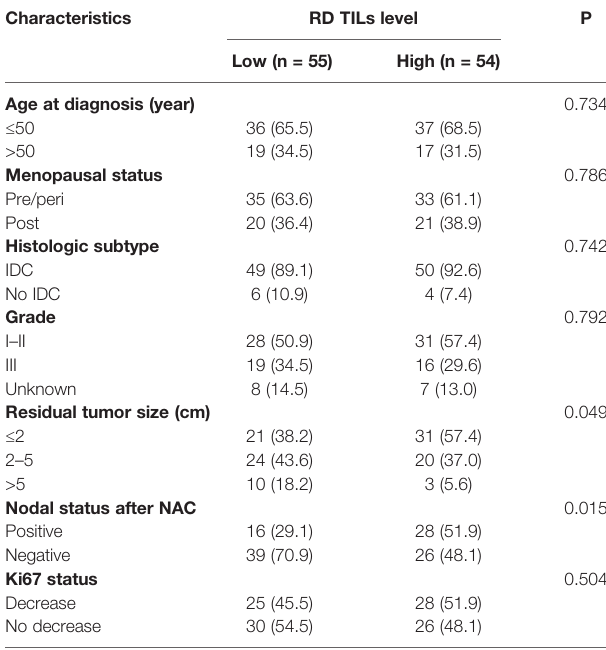
TABLE 3 | The relationship between TILs and other